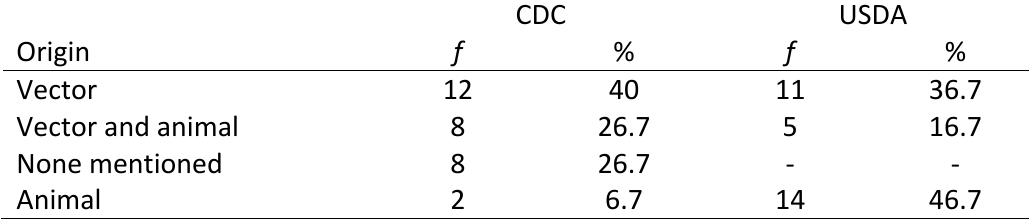
Origin of zoonotic disease referenced in articles on CDC and USDA websites